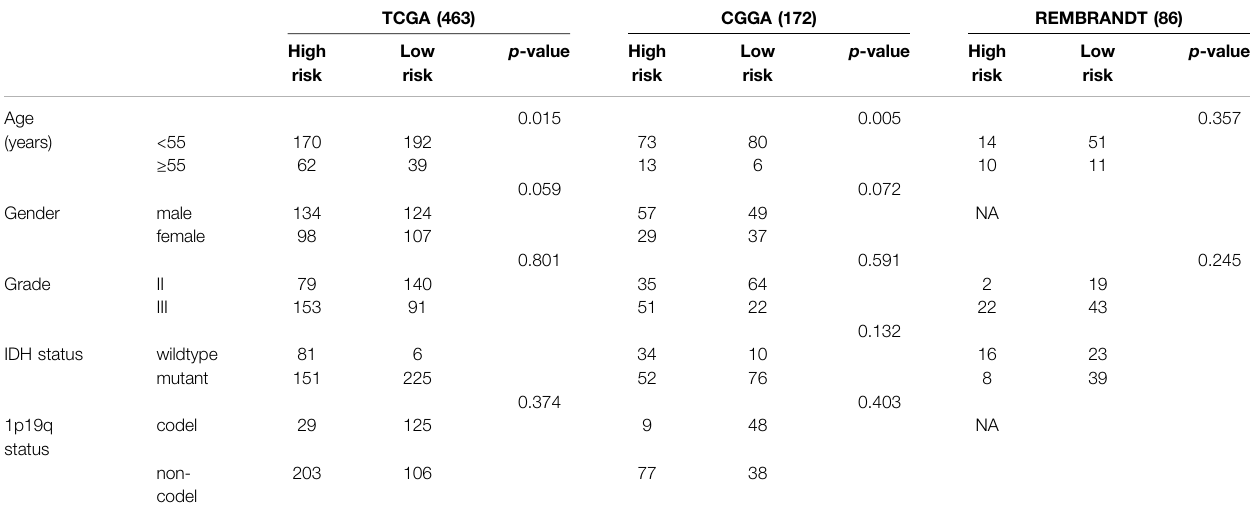
TABLE 1 | Basic characteristics of LGG